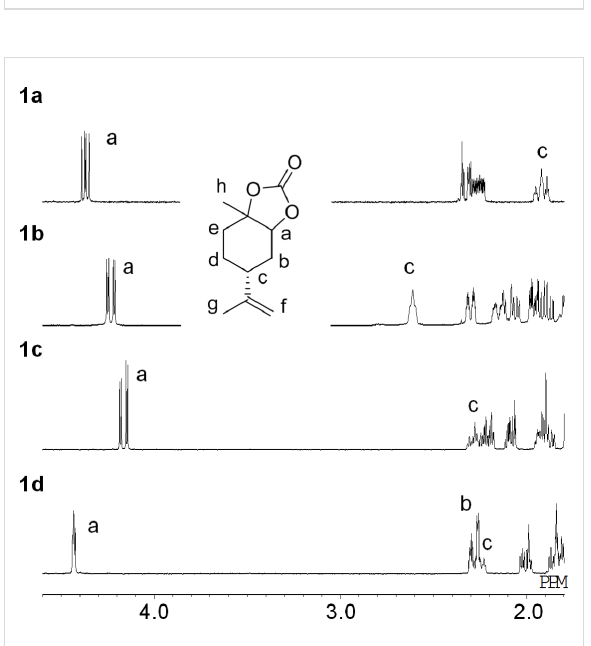
Figure 3: 1 H NMR spectra of LM5CCs 1a – d in CDCl 3